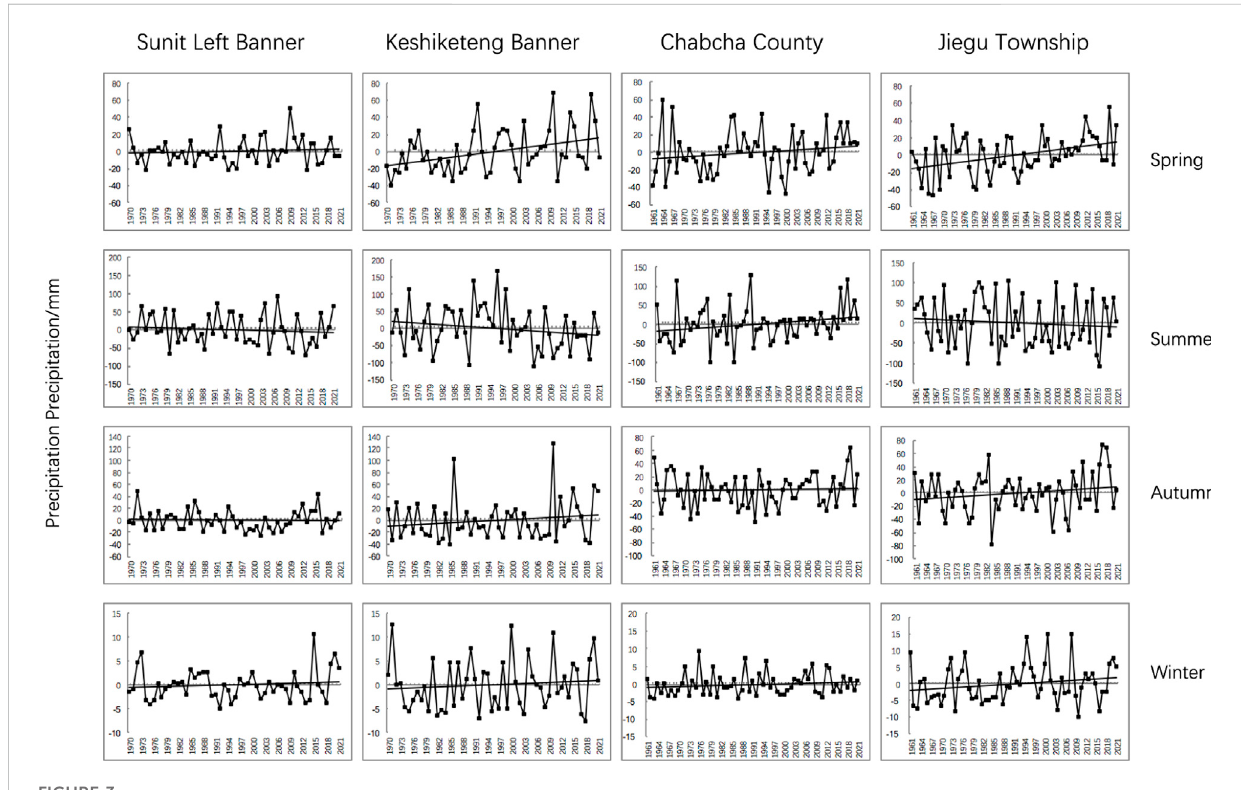
FIGURE 3 Precipitation anomaly of four seasons of four cases (1970/1961 –